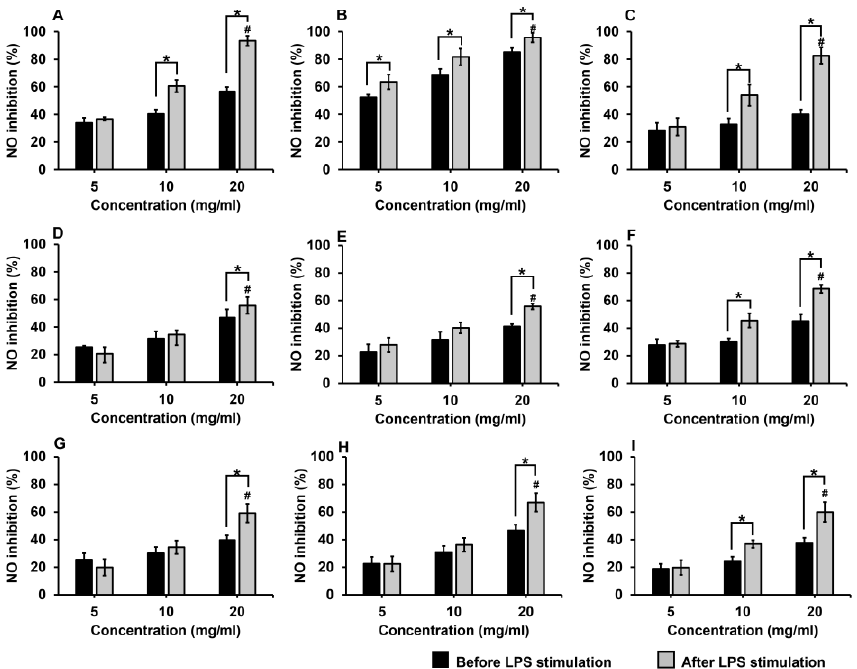
Figure 2. Inhibitory effects of royal jelly samples RJ-LP1 ( A ) and RJ-CM1 – RJ-CM8 ( B – I ) on NO production when treated before and after stimulation of RAW264.7 cells with LPS for 24 h. The data represents mean values of three replicates ± SD. # The significant highest NO inhibition is shown in each sample ( p < 0.05). * The values were significantly different before and after stimulation with LPS of RAW264.7 cells ( p < 0.05).